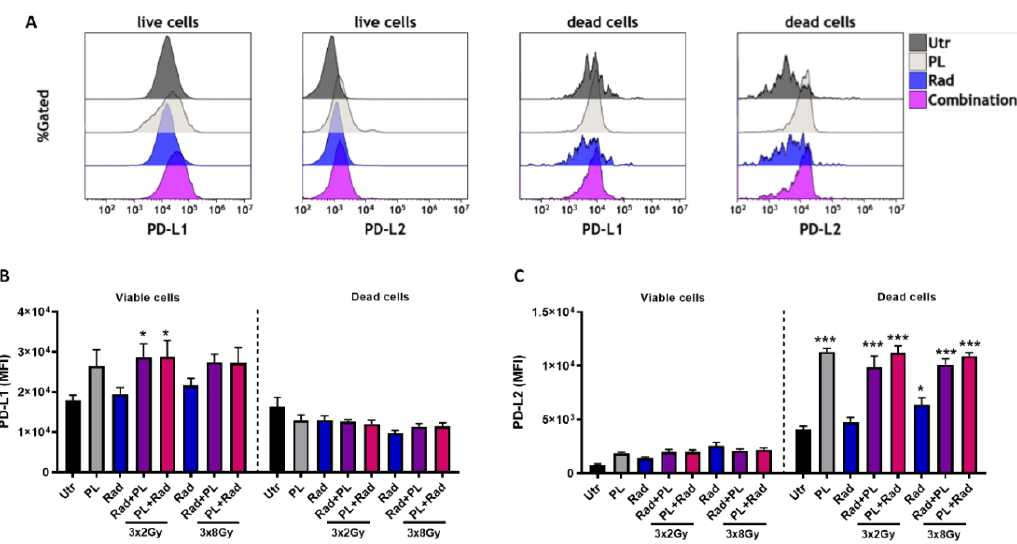
Figure 5. Immune checkpoint analysis in B16F10 melanoma cells. ( A ) representative overlay histograms of PD-L1 and PD-L2 on viable (live) and dead murine B16F10 cells receiving plasma (10 s at 0 h), fractionated radiotherapy (at 0, 24, and 48 h), or both, analyzed by flow cytometry at 24 h after the last radiation dose; ( B , C ), quantification of PD-L1 ( B ) and PD-L2 expression. Data are representative and mean + SE of three experiments. Statistical analysis was performed by one-way ANOVA. Gy = gray, Utr = untreated, PL = plasma, Rad = radiotherapy, MFI = mean fluorescent intensity; * = p < 0.05, *** = p < 0.001.